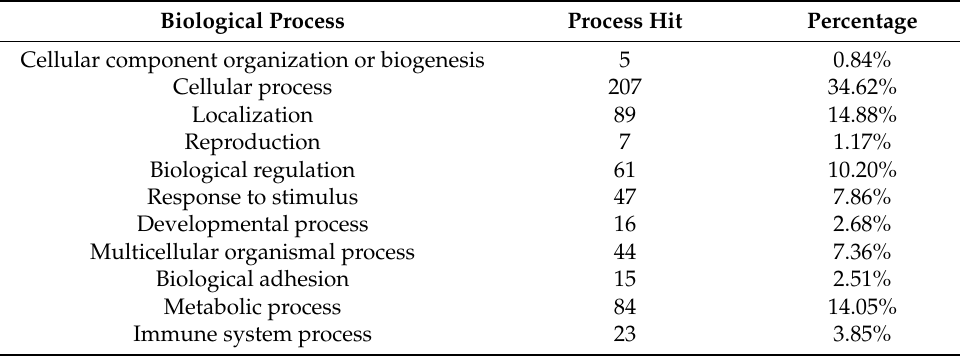
Table 2. Milk extracellular vesicle-proteins related biological